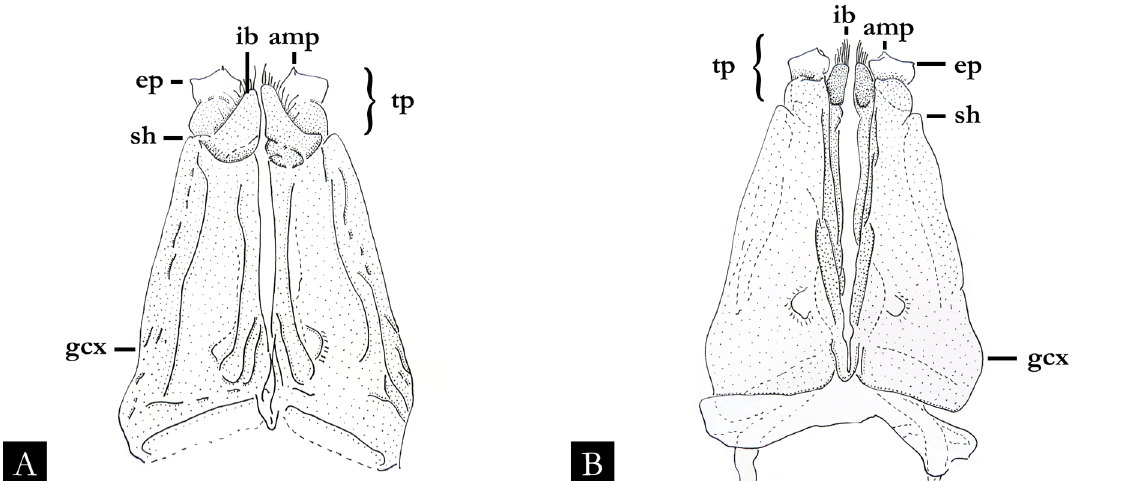
Fig. 61. Schematic drawings of gonopods of Pseudonannolene caulleryi Brölemann, 1929 (modified from Brölemann 1929: figs 24–25). A . Oral view. B . Anal view. Abbreviations: see Material and methods. Images not to